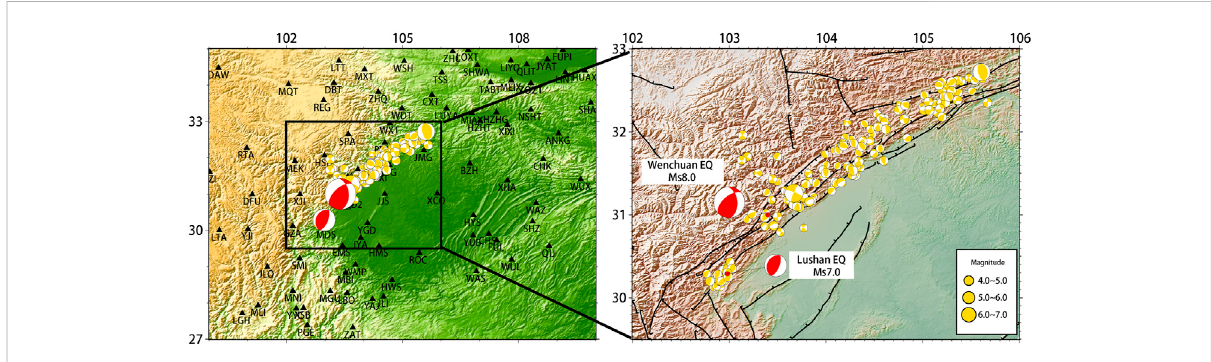
FIGURE 1 Mapofthestudyareawiththebroadbandseismologicalstationsusedinthisstudy(black triangles).Thezoomedmapshowstheearthquakesof the entire seismic sequence, with many of the identi fi ed active fault traces in the region.